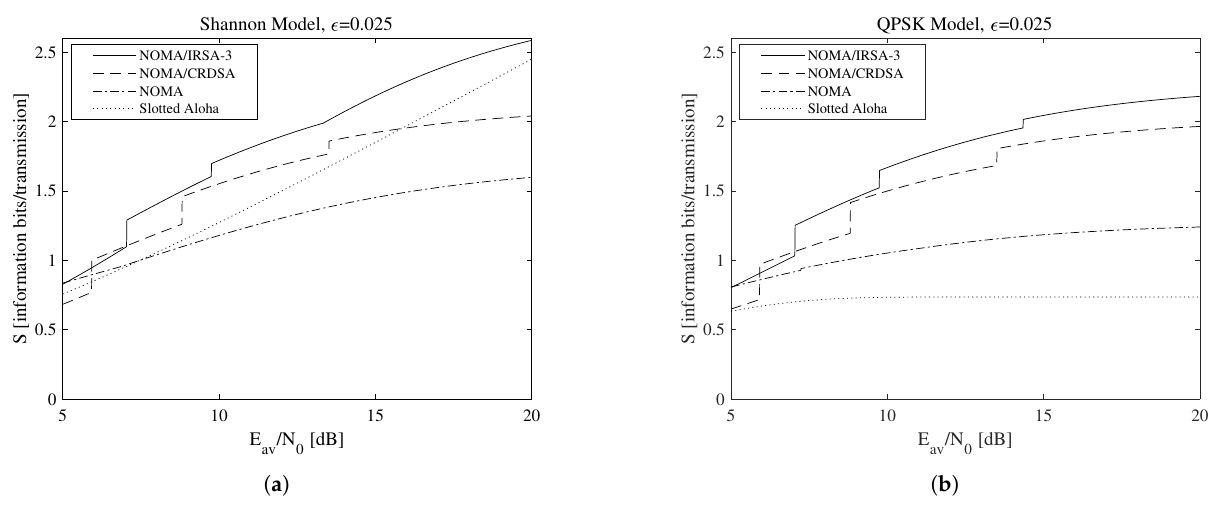
Figure 7. Maximum throughput as a function of the available average SNR for (cid:101) = 0.025: ( a ) Shannon bound, ( b ) QPSK